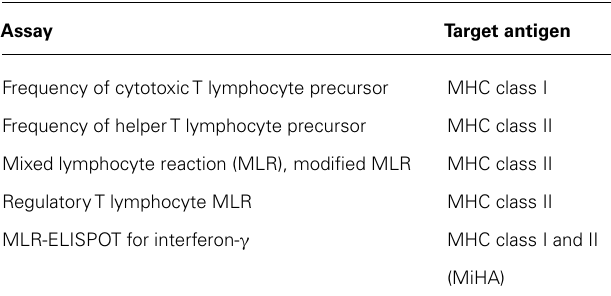
Table 2 |Assays to detect allogeneic antigens.